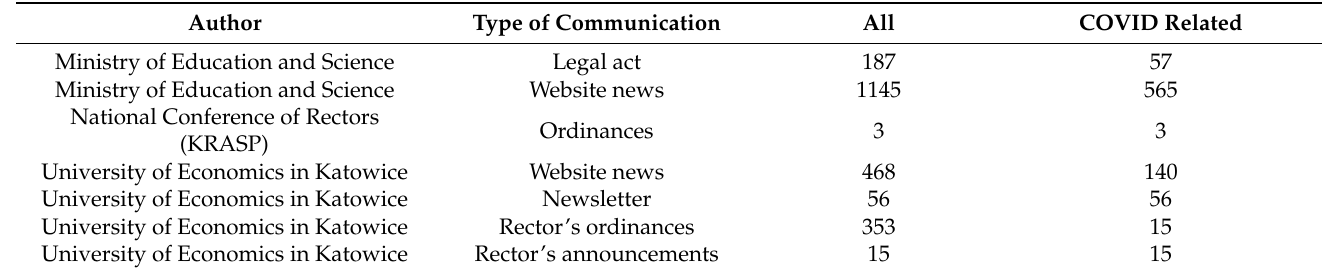
Table 1. Number of messages with the authors and type of communication.